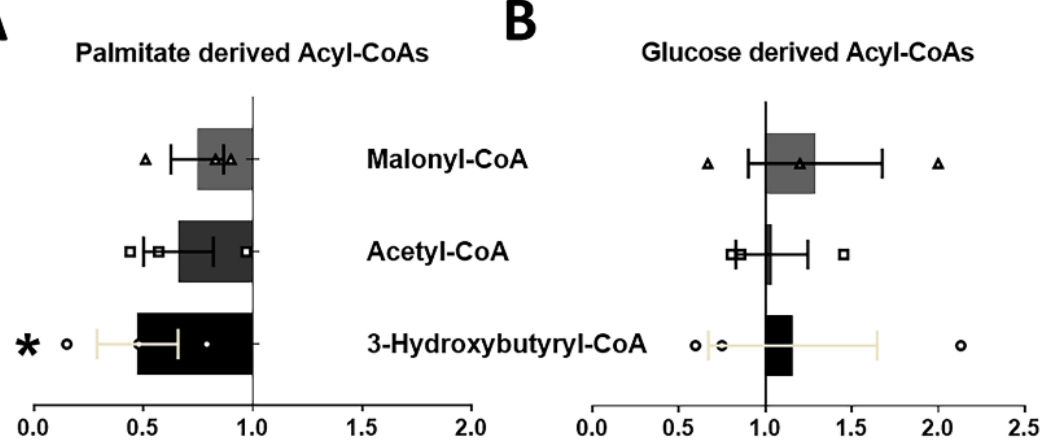
Figure 2. GRK2 negatively impact fatty ‐ acid catabolism. ( A ) Palmitate ‐ derived isotopically labeled malonyl ‐ CoA, acetyl ‐ CoA, and 3 ‐ Hydroxybutyryl ‐ CoA in Grk2TG ACMs normalized to NLC. ( B ) Same as A but glucose ‐ derived acyl ‐ CoAs. Data were normalized to NLC ( n = 3 hearts/condition, mean ± SEM; * p < 0.05).